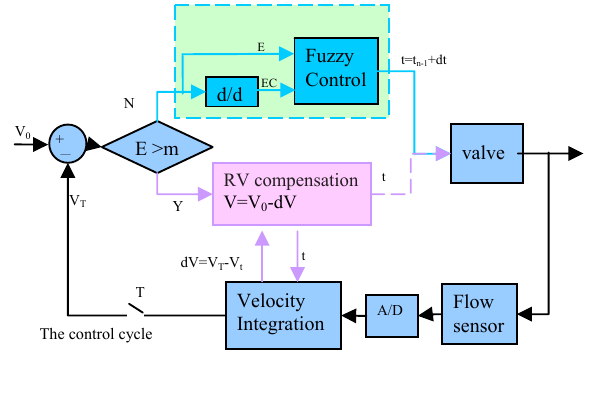
Figure 10. The schematic of the intelligent compound control